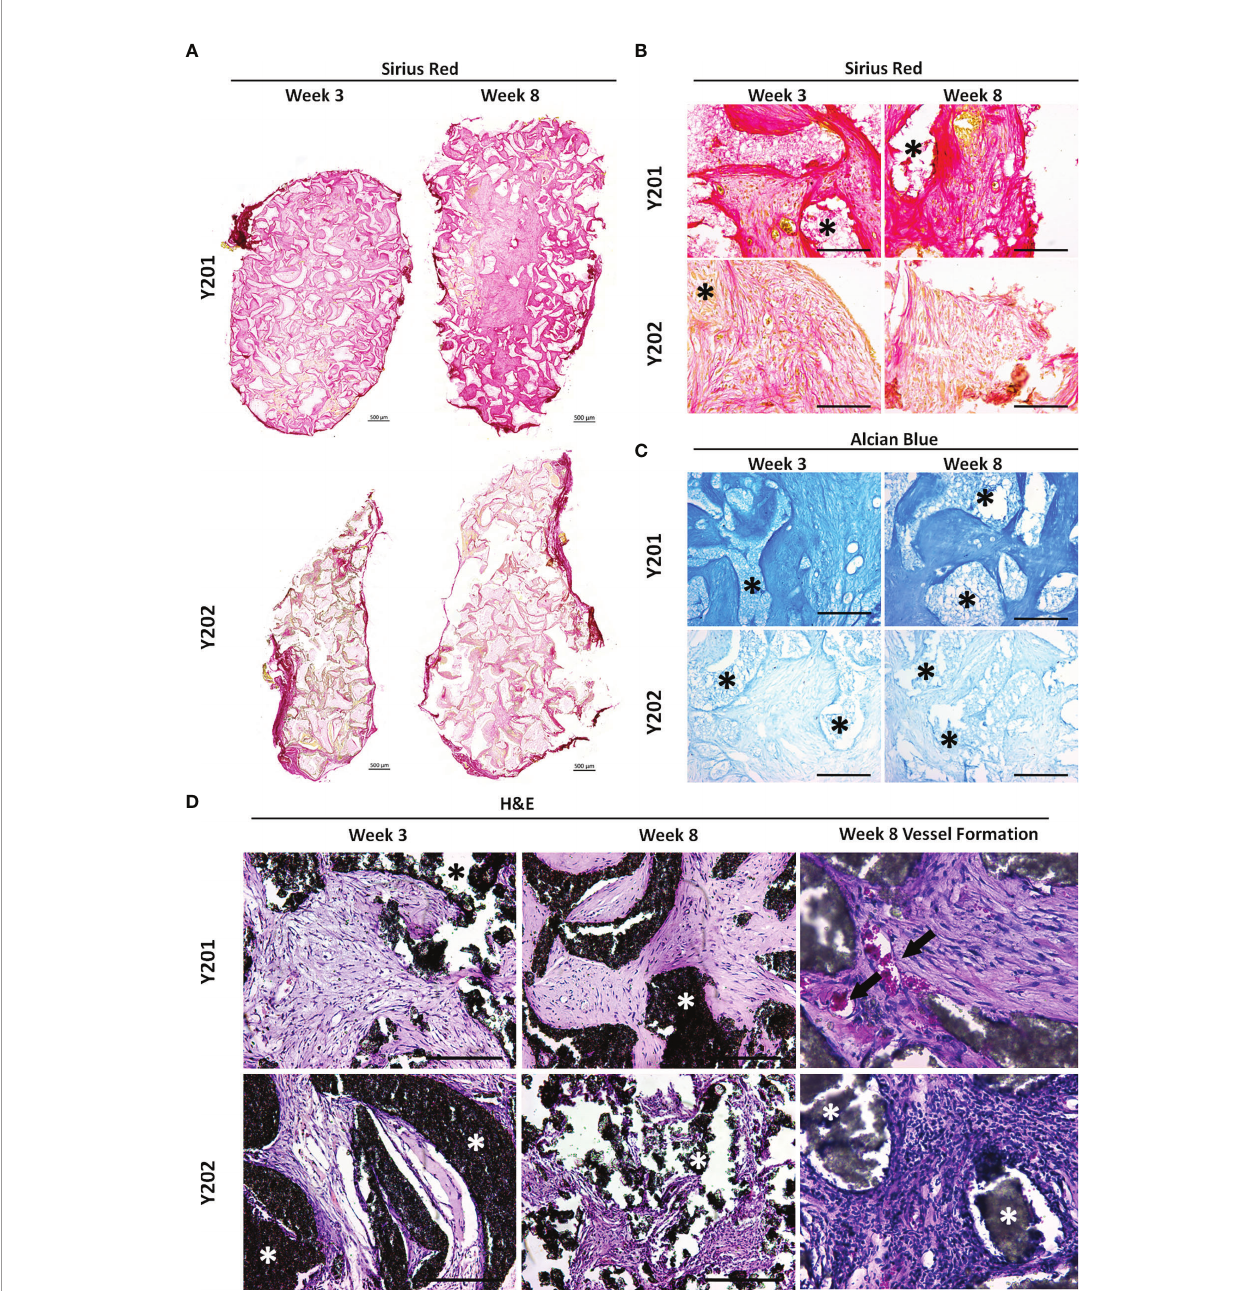
FIGURE 5 | In vivo tissue generation in HA scaffolds loaded with CD317 neg Y201 or CD317 pos Y202 MSCs. (A, B) Histological staining of recovered implants using Sirius Red for collagen formation and (C) Alcian Blue for proteoglycan synthesis at 3 and 8 weeks post-implantation in HA scaffolds loaded with either CD317 neg Y201 MSCs and CD317 pos Y202 MSCs. (D) Haematoxylin and eosin staining comparting tissue and blood vessel formation at 3 and 8 weeks post-implantation in HA scaffolds loaded with CD317 neg Y201 MSCs and CD317 pos Y202 MSCs. Scale bars = 250 m m (Part A Scale bars = 500 m m). Asterisks = HA particles, arrows = blood vessels. *p <